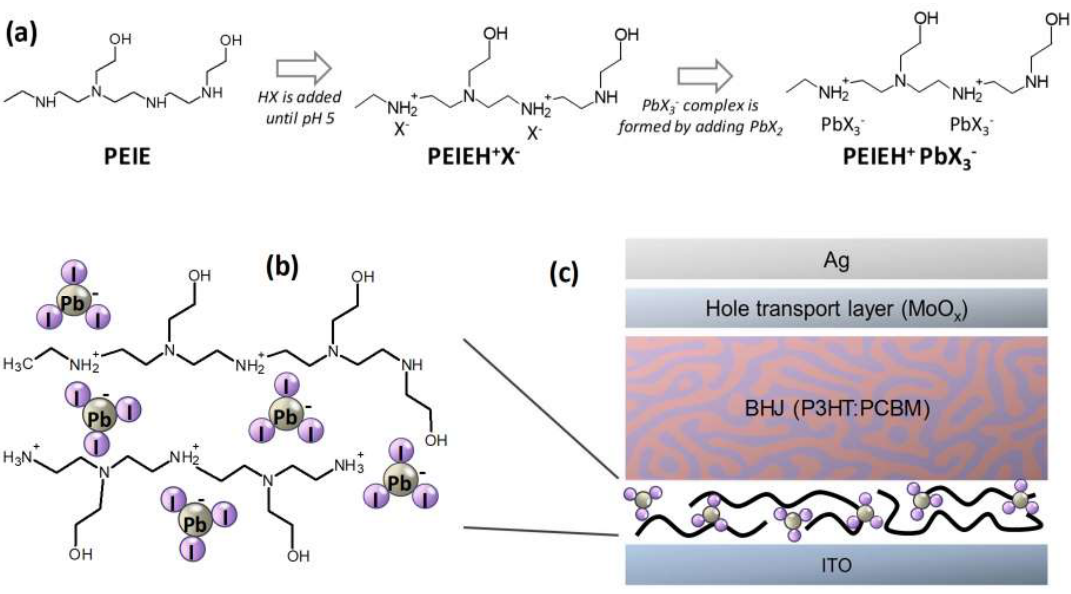
Figure 1. Schematic illustrations showing ( a ) the preparation of a hybrid lead halide polyelectrolyte. ( b ) Conceptual diagram of the chemical structure of the ethoxylated polyethyleneiminium lead triiodide (PEIEH + PbI 3− ) polyelectrolyte and ( c ) device diagram showing the application of ethoxylated polyethyleneimine-lead halide complex (PEIE:PbX 2 ) polyelectrolytes as a solution-processible hybrid electron transport layer in an inverted OSC.